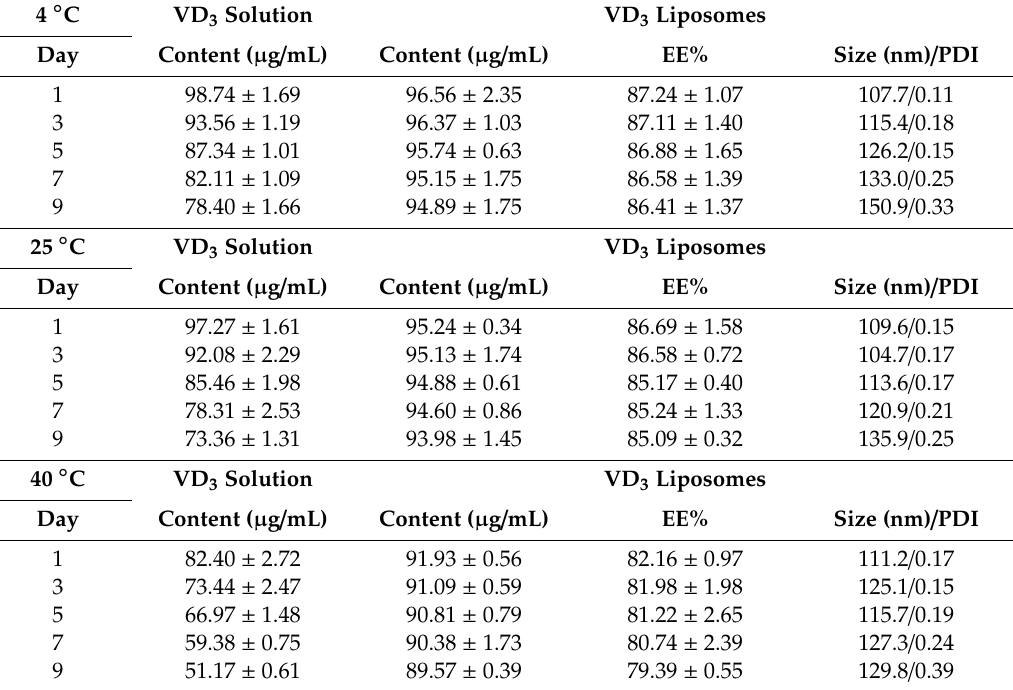
Table 5. The stability of VD 3 liposomes in different time and temperature. Polydispersity index (PDI).